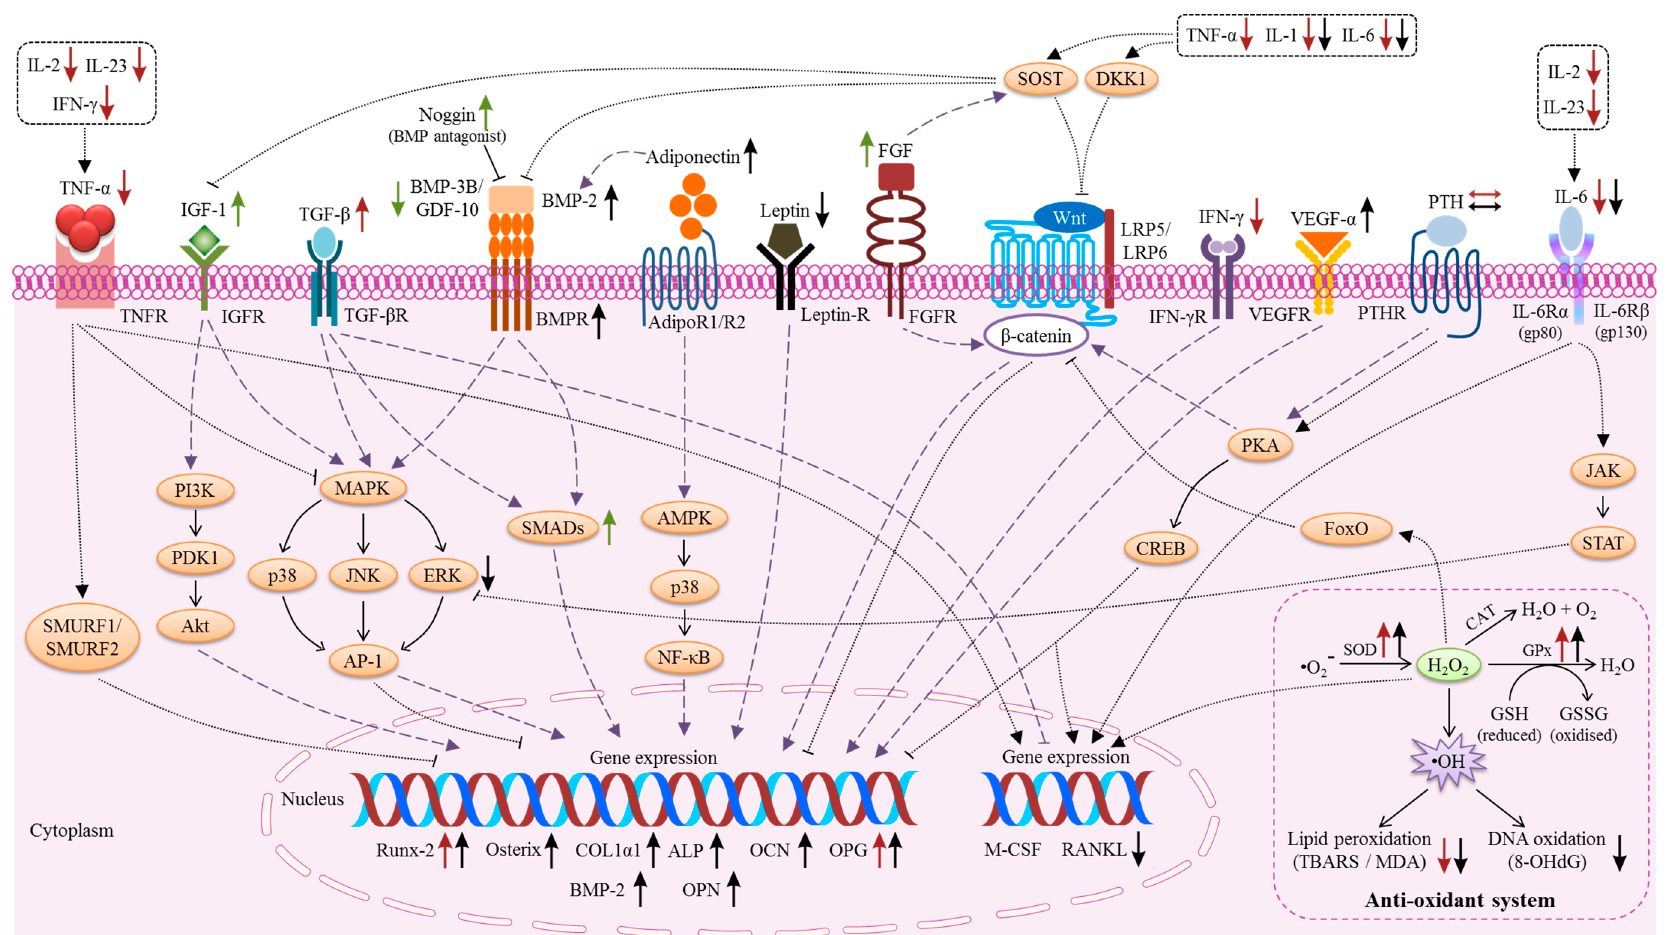
Figure 1. The signalling in osteoblasts for the regulation of bone metabolism. Under normal conditions, several essential signalling events can be activated to initiate the activity of bone formation (indicated by the purple dotted line, — — ). Inflammation, oxidative stress, and hyperparathyroidism cause inhibition of bone formation via several pathways (indicated by the black dotted line, ······ ). The effects of TF (red arrows), T3 (black arrows) as well as high doses of TF and T3 (green arrows) are indicated.